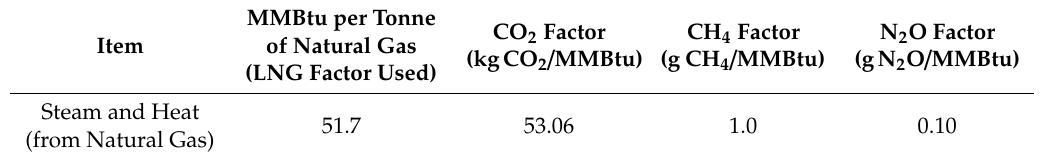
Table 4. Steam and heat emission factors assuming natural gas is entirely used at 80% efficiency.